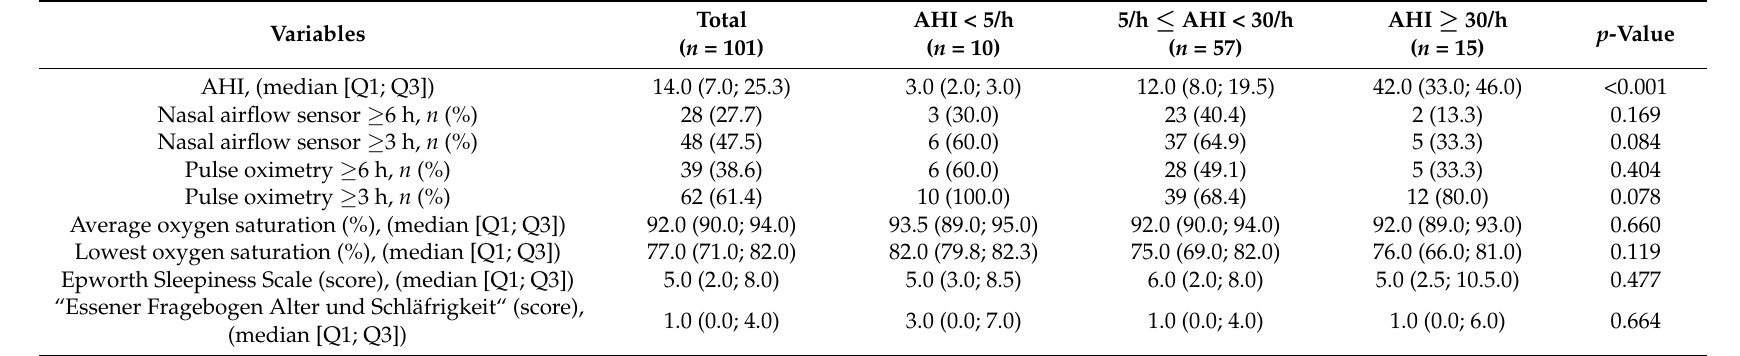
Table A2. Sleep-related characteristics of the study cohort also split by alternative AHI category. Variables